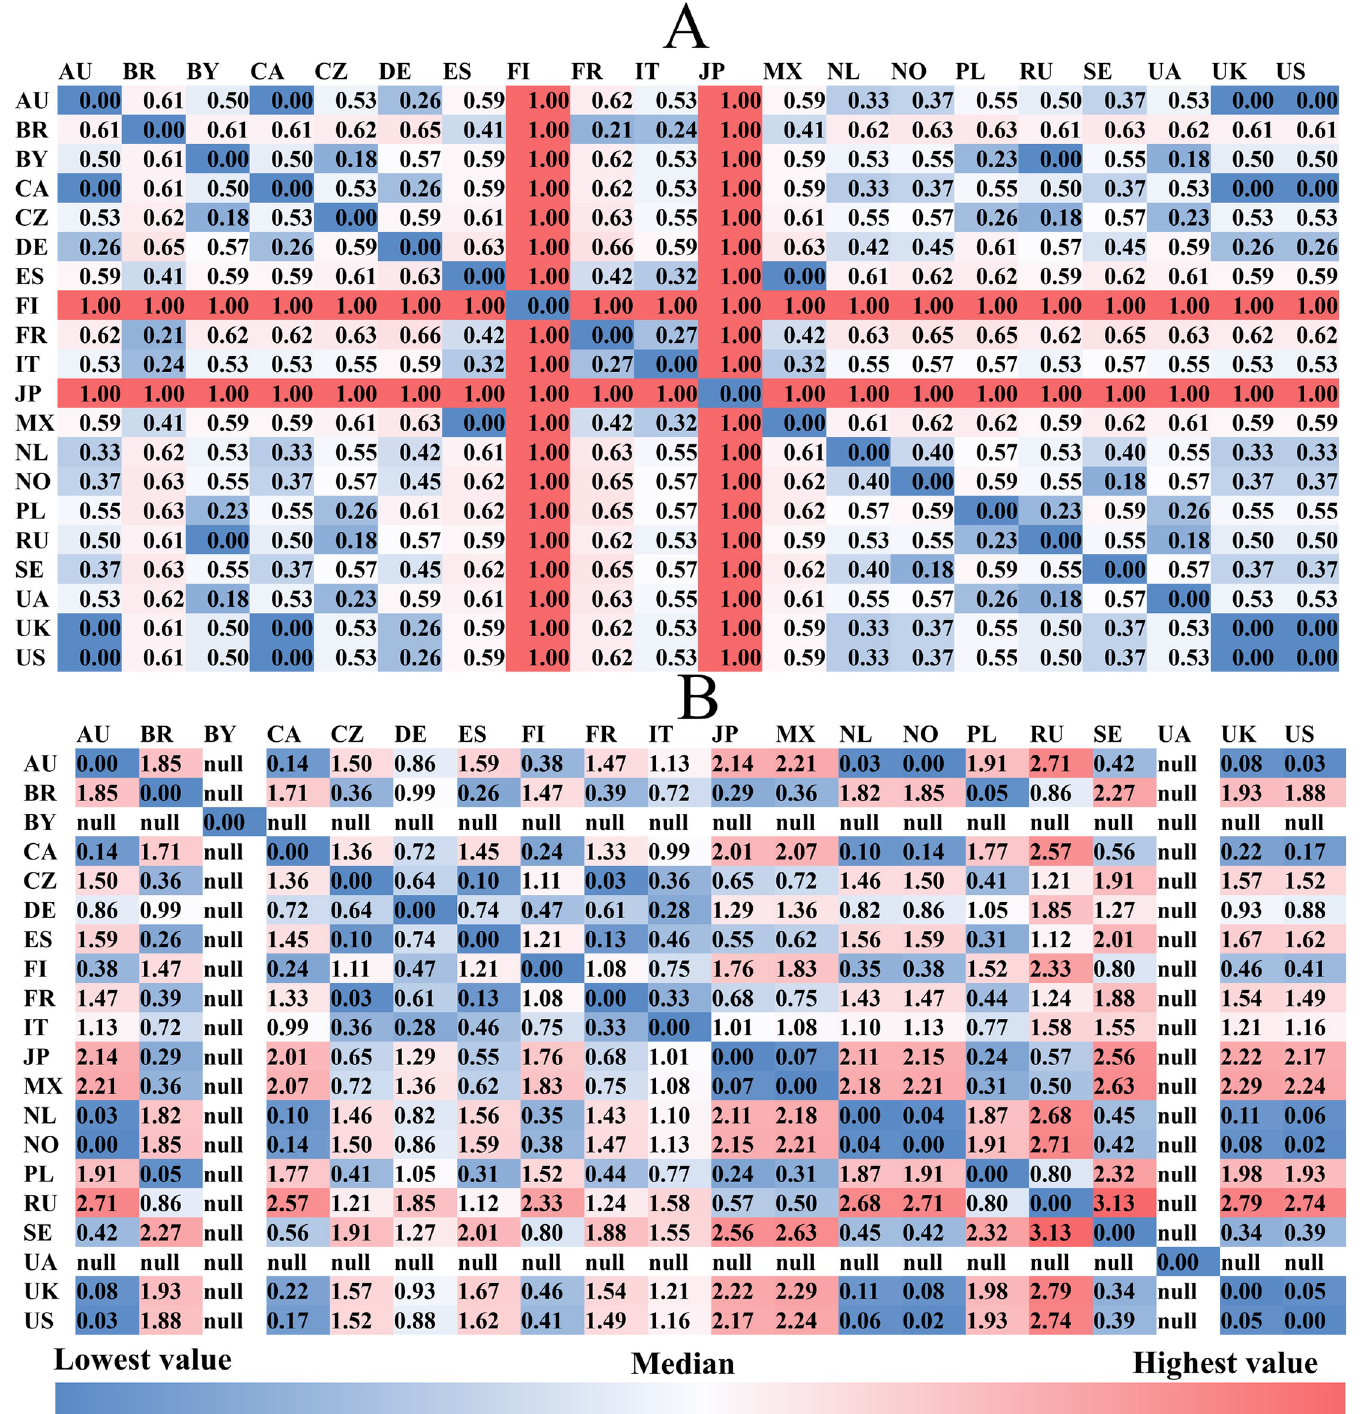
Fig 7. The between-country linguistic and cultural distances. (a): linguistic distances; (b): cultural distances ; “null” for UA and BY is due to the missing value in the original culture scores of these countries released by Hofstede (http://geerthofstede.com/research-and-vsm/dimension-data-matrix/). Although cultural scores for BY and UA are unavailable, other aspects of these two countries have values (e.g., geographic, economic and linguistic aspects, and friendship connections) which are included in the QAP regressions.